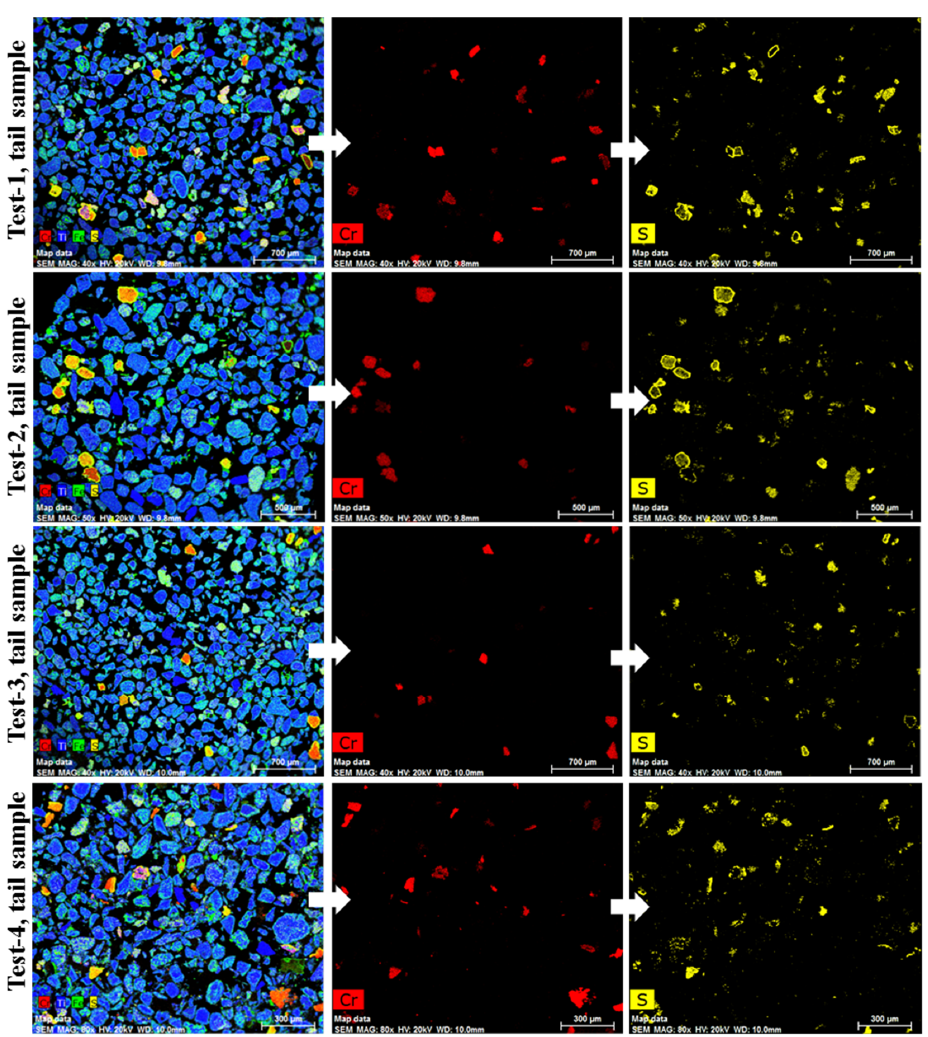
Figure 13. EDX mapping of tail samples obtained after flotation.